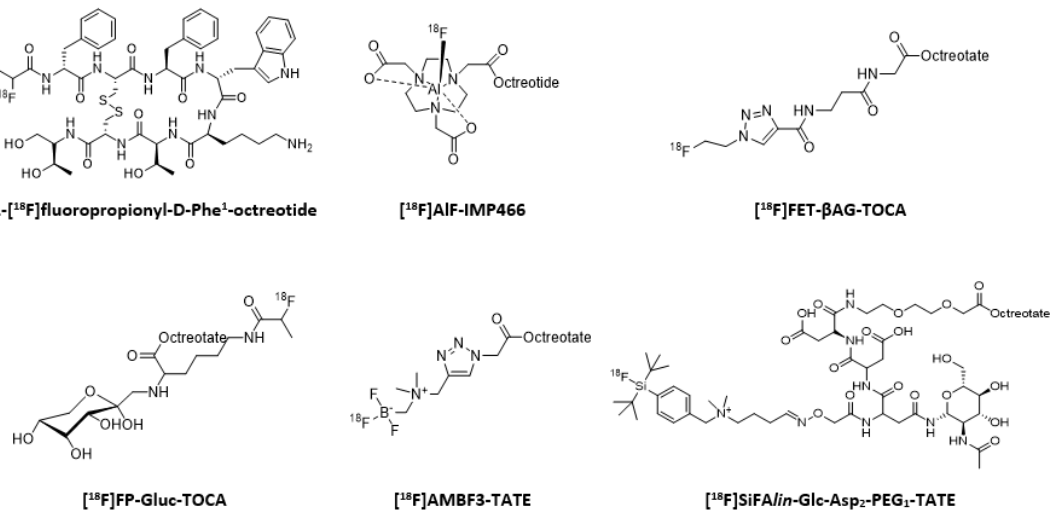
Figure 9. [ 18 F]-labeled somatostatin analogs.